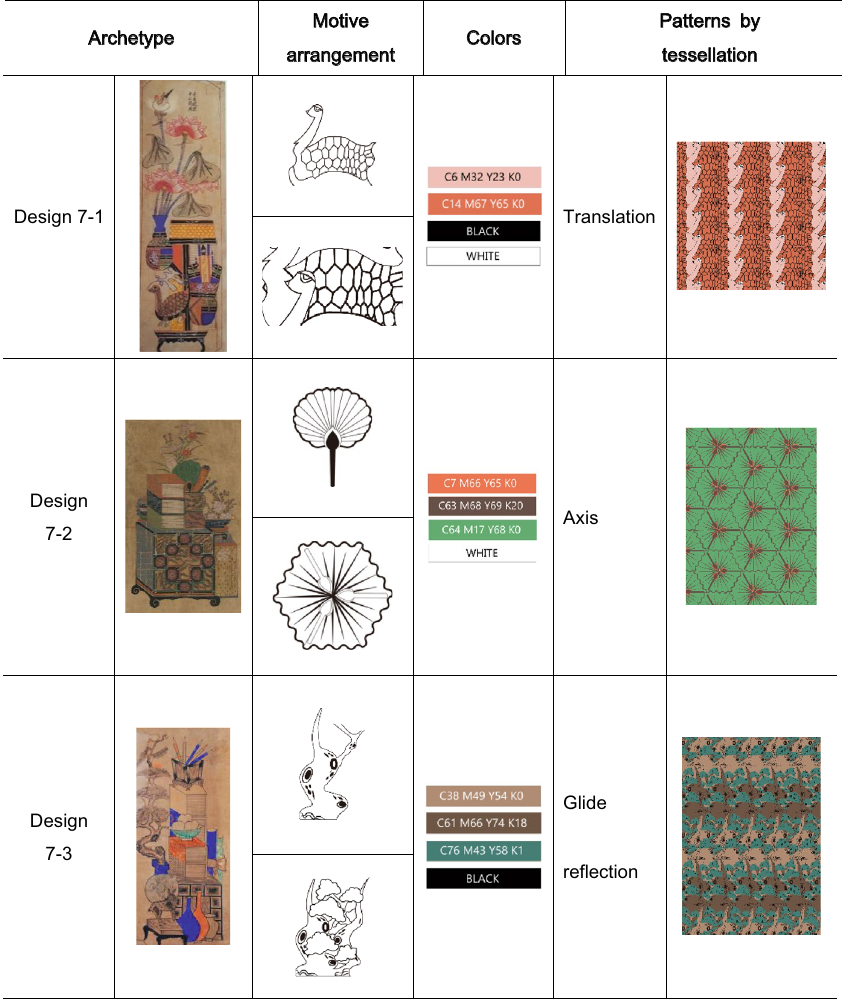
Table 7 Textile pattern design using protection